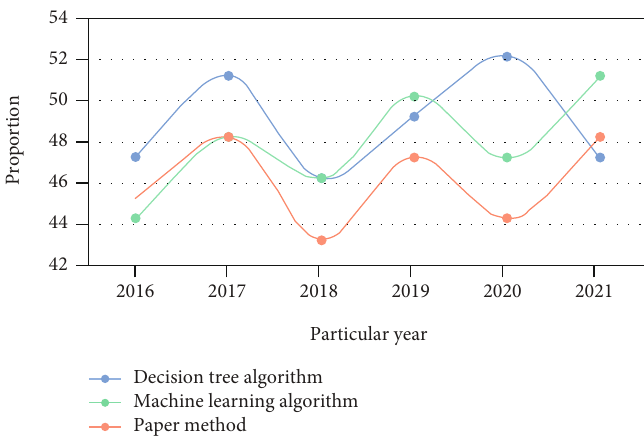
Figure 7: Average power outage time of plant